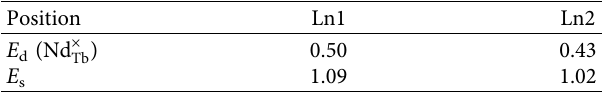
× )) and sub- d (Nd Tb